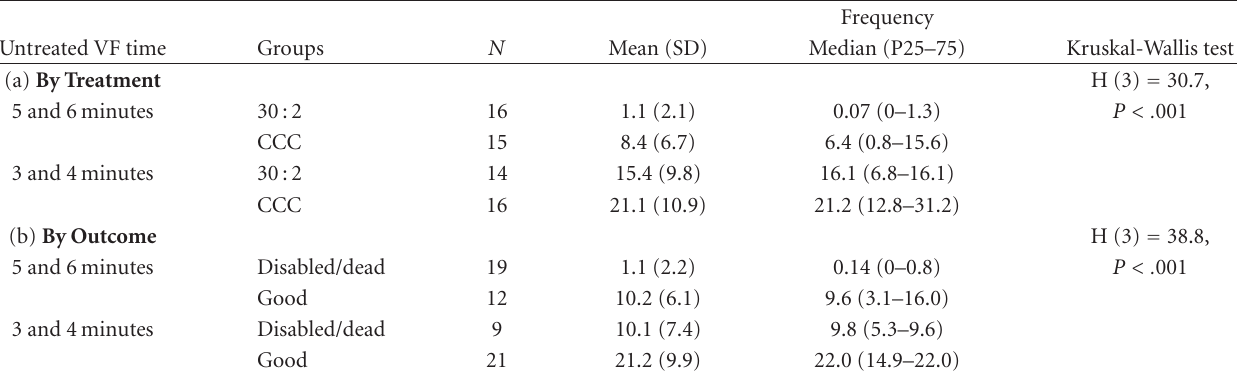
Table 1: (a) Frequency of gasping in relation to the resuscitation protocol applied. (b) Frequency of gasping in relation to the 24-hour neurological